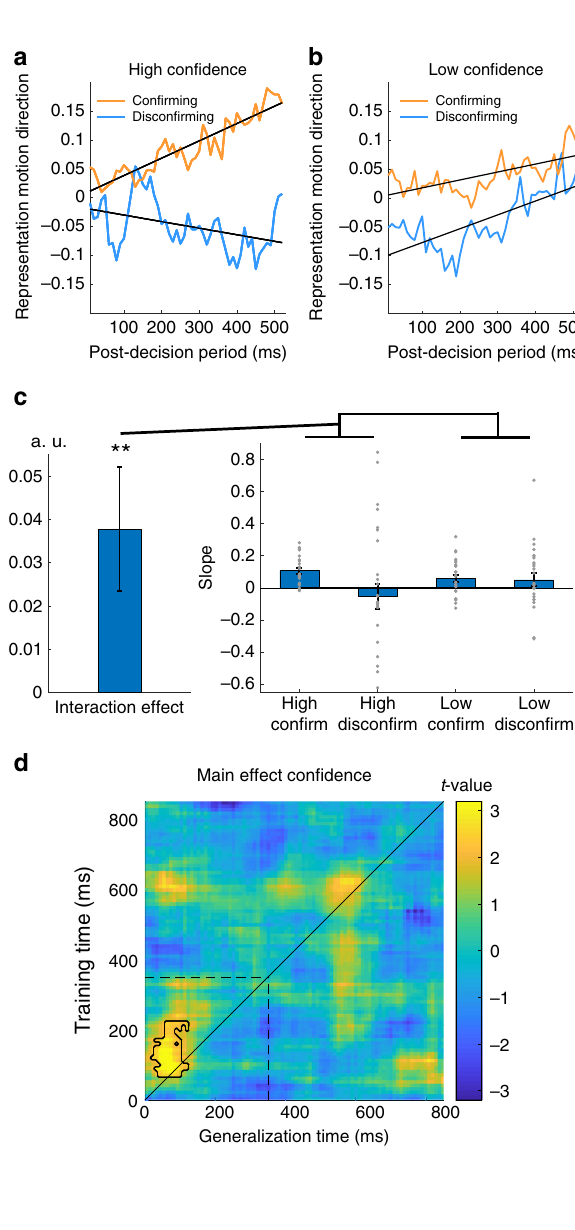
Fig. 3 Outline of MEG analysis for quantifying accumulation of post-decision evidence at a neural level (MEG study 3, n = 25 participants). a We trained a machine-learning classi fi cation algorithm on the pre-decision phase using MEG activity to predict left vs. right choices, and reapplied this classi fi er to the corresponding time point during the post-decision phase. The distance of each trial to the separating hyperplane provides a graded measure of neural evidence for a left or right decision, with changes in the classi fi er prediction within each trial providing a neural metric of evidence accumulation (see right hand panel). The inset shows the temporal generalization of decoding accuracy from the pre- to post-decision phases, indicating that the pre-decision classi fi er generalises to the post-decision phase along the major diagonal (i.e. corresponding time-points). AUC = area under the curve, DV = decision variable. b Grand average of the left/right classi fi er prediction in response to post-decision evidence. The light grey line shows the change in neural representation when rightward motion is presented and the black line shows the change in neural representation when leftward motion is presented. Regression lines show fi ts to the group-averaged data for visualisation purposes. Note that positive classi fi er values indicate evidence for a rightward decision and negative values evidence for a leftward decision. c Contributions of sensors to decoding left versus right decisions. The group average of contributions for each sensor is presented. In line with previous research on the neural correlates of evidence accumulation, sensors in centro-parietal regions made the highest contributions to decodability of (abstract) left versus right decisions. d – f Validation of neural metrics of post-decision evidence accumulation. Neural measures of the slope and starting point (intercept) of evidence accumulation extracted from the post-decision phase were entered as simultaneous predictors of ( d ) reaction times ( e ) accuracy and ( f ) con fi dence of the fi nal decision. Fixed effects from a hierarchical regression model are presented ± SEM. Hierarchical regression (two-tailed): d ** p = 0.005; e * p = 0.045, ** p = 0.002; f ** p = 0.002, *** p = 0.0004.